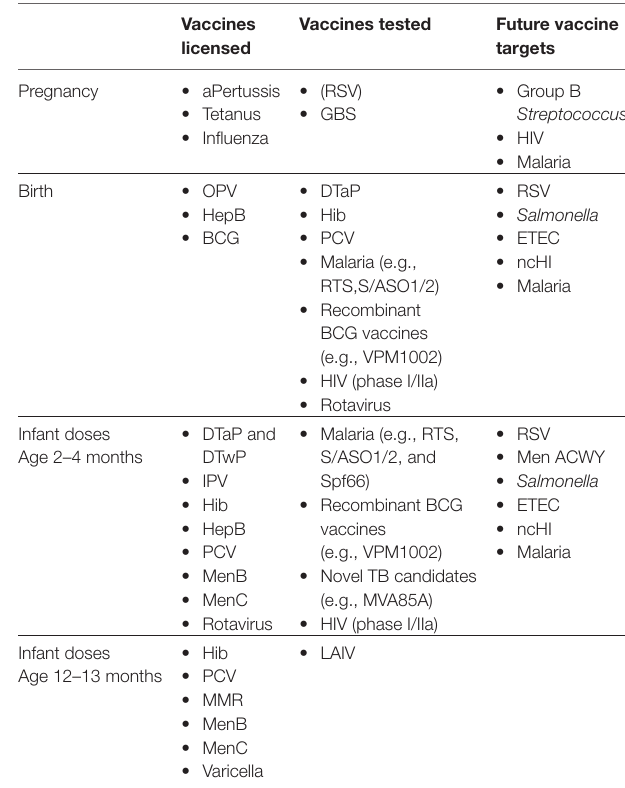
TABLe 1 | Immunizations given at different